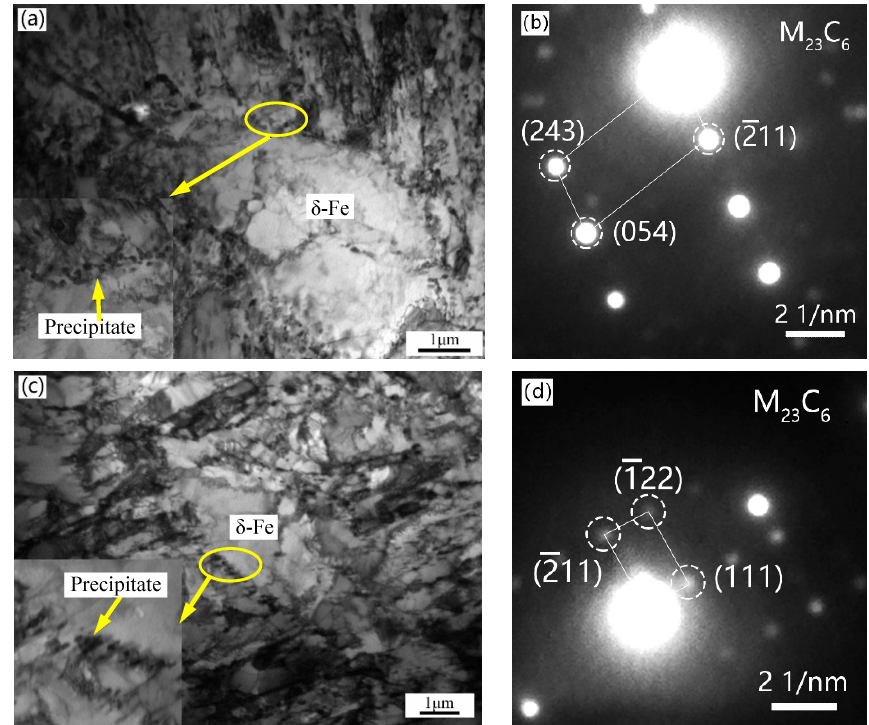
Figure 8. TEM images of the δ -ferrite in 2# steels after heat treatment ( a ) δ -ferrite in 2L steel (high Si and low temperature), ( b ) SAED pattern of the precipitates around the δ -ferrite in 2L, ( c ) δ -ferrite in 2H steel (high Si and high temperature), and ( d ) SAED pattern of the carbides around the δ -ferrite in 2H.